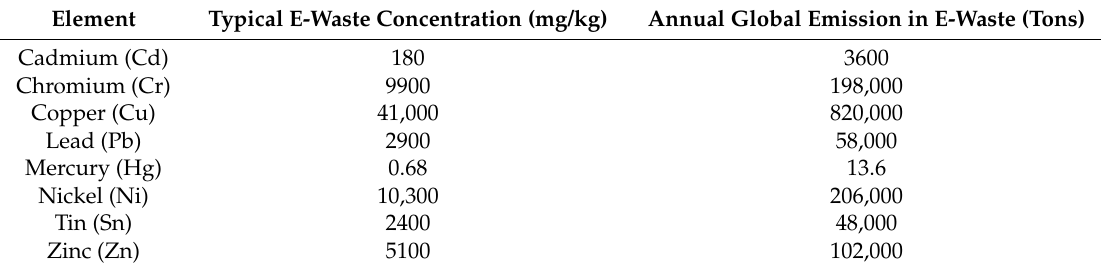
Table 1. Elements present in the environment from the disposal of e-waste [10] Element Typical E-Waste Concentration